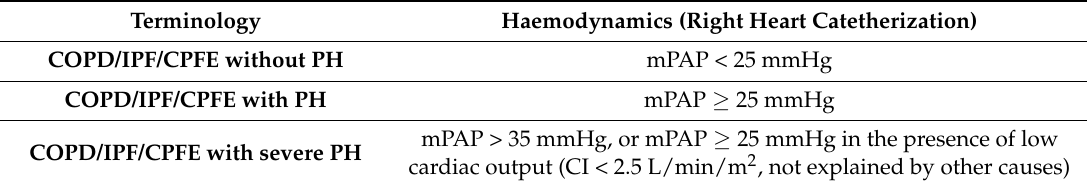
Table 1. Hemodynamic classification of pulmonary hypertension (PH) due to lung disease. Terminology Haemodynamics (Right Heart Catetherization) COPD/IPF/CPFE without PH mPAP < 25 mmHg COPD/IPF/CPFE with PH mPAP ≥ 25 mmHg mPAP > 35 mmHg, or mPAP ≥ 25 mmHg in the presence of low COPD/IPF/CPFE with severe PH cardiac output (CI < 2.5 L/min/m 2 , not explained by other